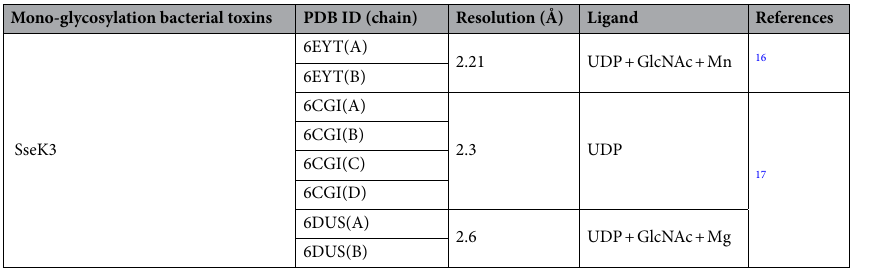
Table 2. Bacterial mono-glycosyltransferase toxins. All 30 crystal structures of glycosyltransferase toxins were obtained from the RCSB PDB site, and a total of 51 chains in the asymmetric unit were separated into four groups consisting of apo (11 chains) and ligand-bound O-linked toxins (18 chains) and apo (7 chains) and ligand-bound N-linked NleB/SseK toxins (15 chains). Bold toxins in TcnA, NleB2, and SseK2 have an Asx-turn in the catalytic DxD motif, which is tightly tied to the first aspartate side chain of the DxD motif. The other toxins have a free side chain of the first aspartate in the DxD motif only tied in the backbone C10 H-bond Type-I-turn, one of the β